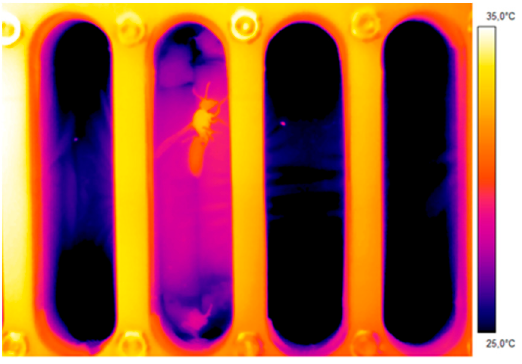
Figure 2. Thermogram of a wasp ( Polistes biglumis ) in a measurement chamber to measure the endothermic activity and CO 2 production rate.